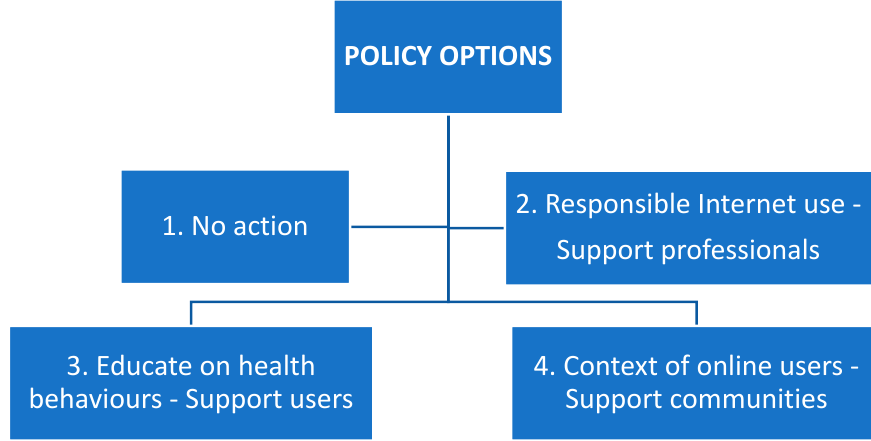
Figure 2. Policy options derived from the present literature review.